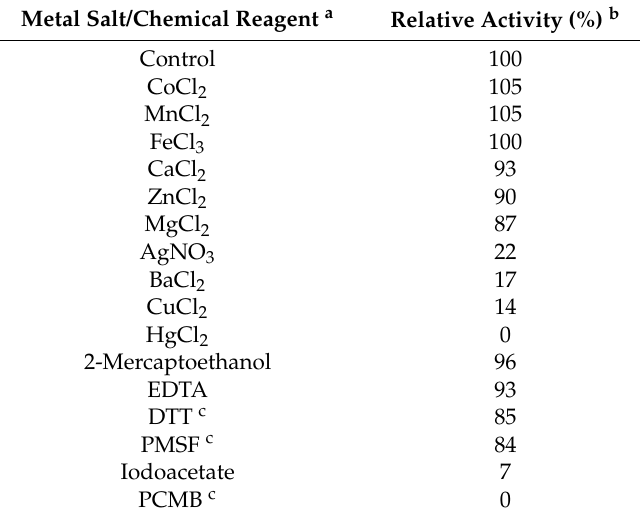
Table 2. Effect of metal salts and chemical reagents on the activity of recombinant β -glucosidase from a Y. lipolytica transformant (pYLSC1- bgl ).